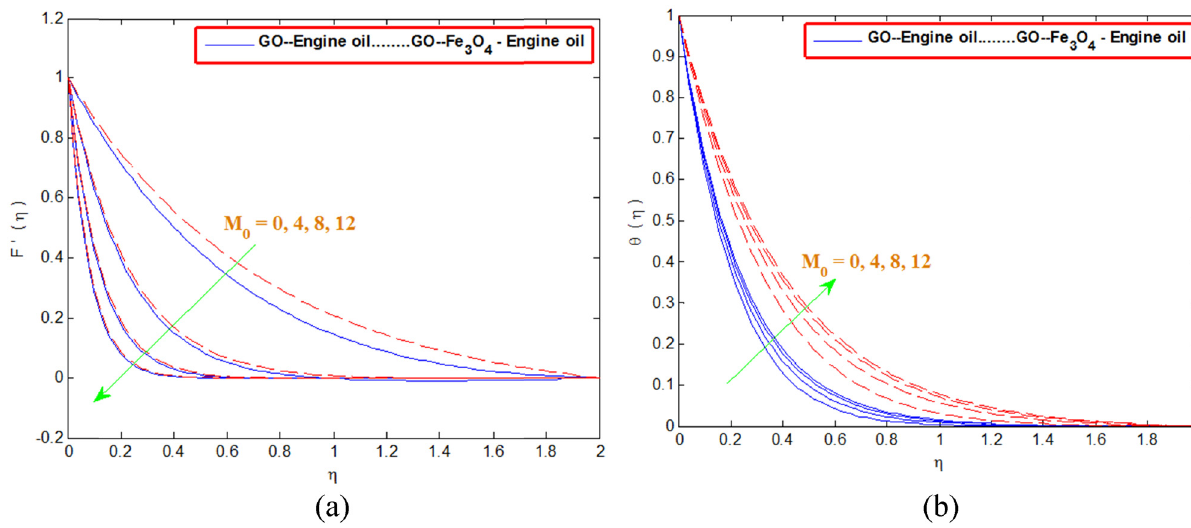
Figure 6: Change in ( a ) velocity and ( b ) temperature with M 0